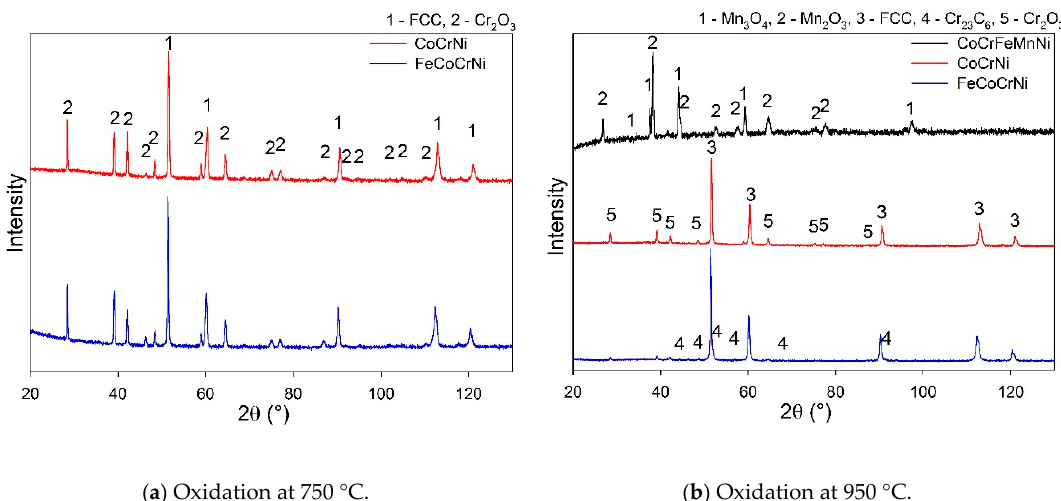
Figure 4. Phase analysis of the oxide scales formed on the alloys after 150 h of oxidation. The quantitative analysis of the phases is summarized in Table 2.